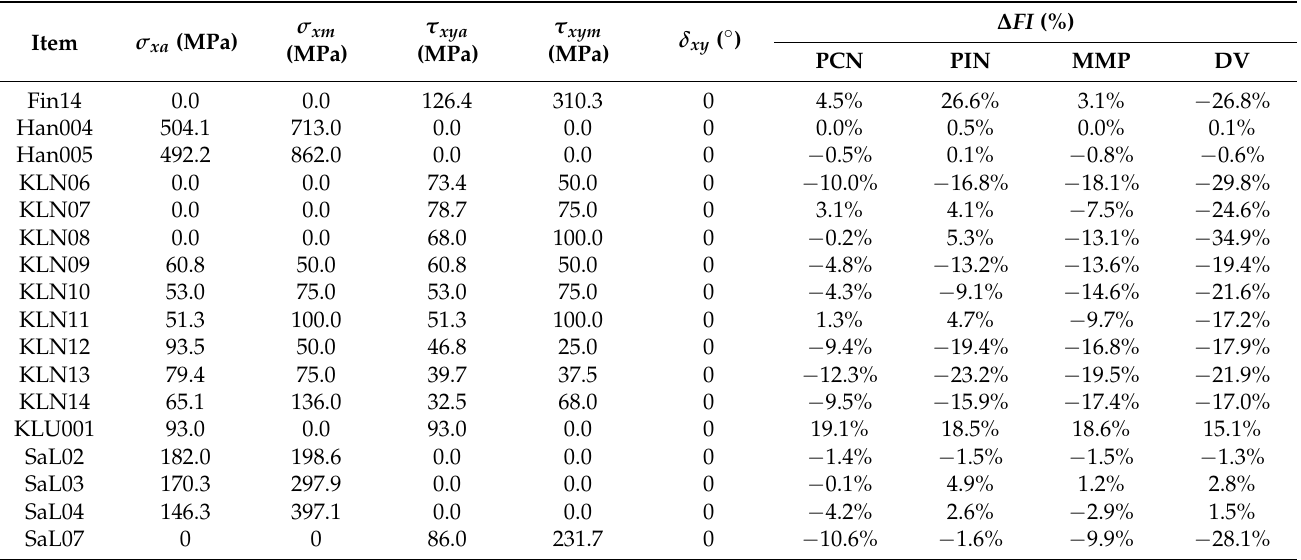
Table 6. The cases of plane bending-torsion load in the AMSD25 data set and the response of the reference multiaxial fatigue strength criteria to them.